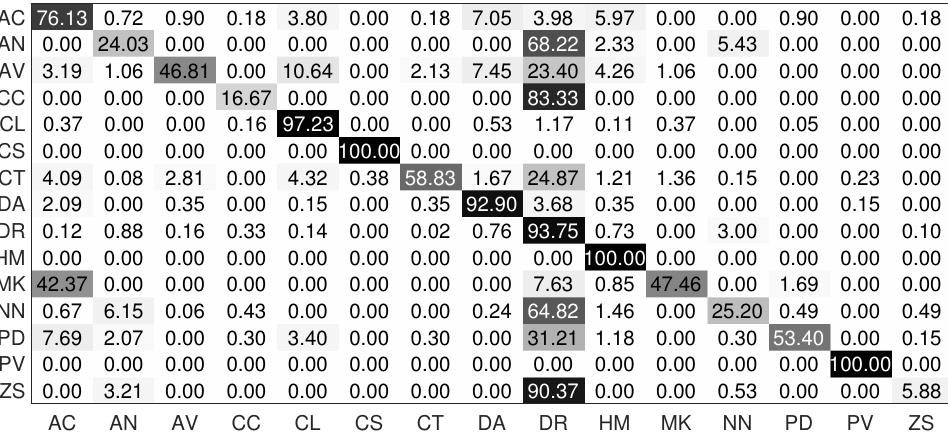
Figure 4. Confusion matrix of classic transfer learning of ResNet50 on the LCF-15